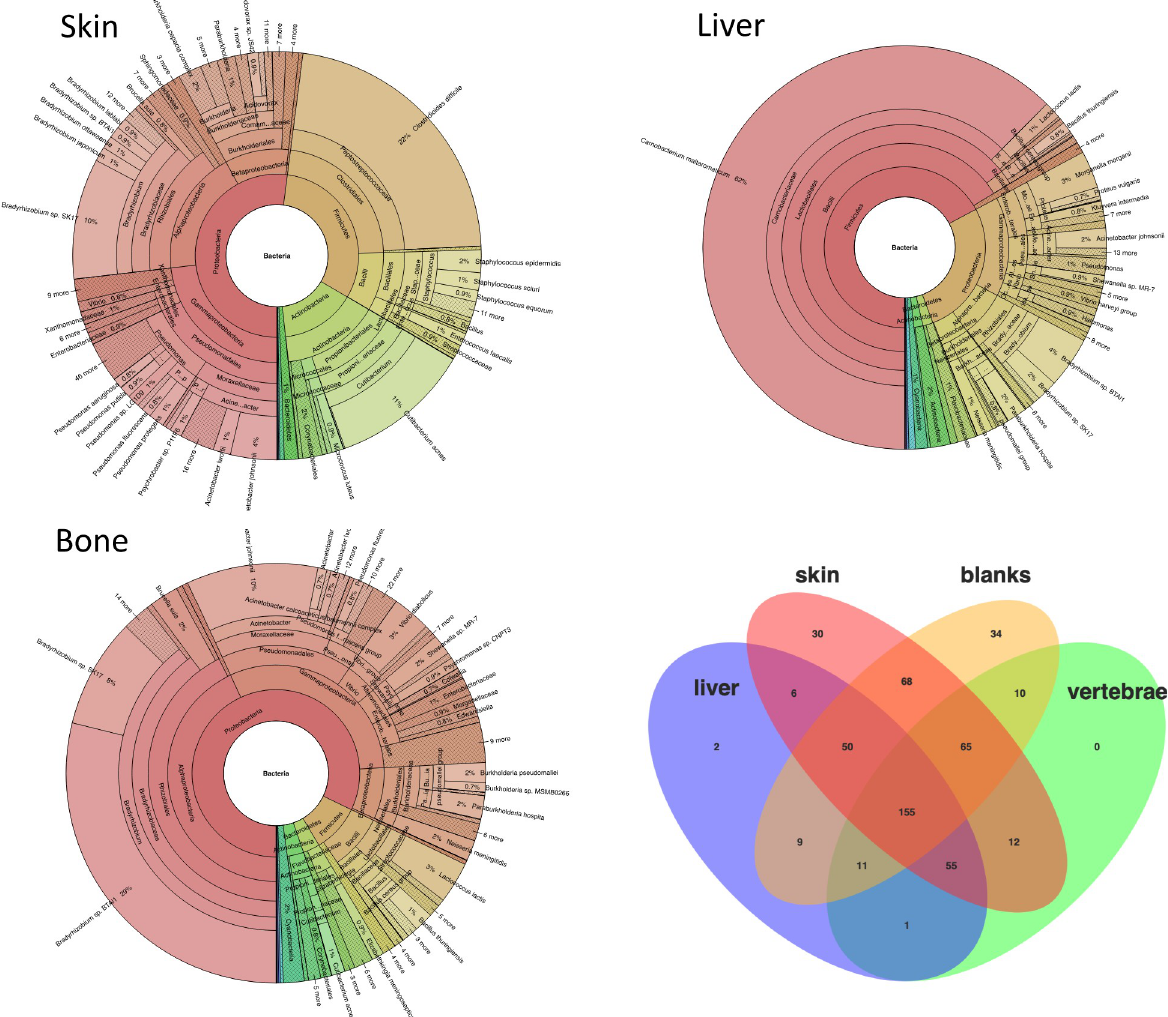
Fig 3. Metagenomic profiling. Bacterial metagenomic diversity visualized in Krona and Venn (lower right) plots for the three tissue types. The diversity is presented at species-level and includes only NCBI refseq taxa with > 5 sequence matches. Colors denote taxonomic groups found within the various bacterial phyla as according to Krona visualization. Blanks denote negative extraction